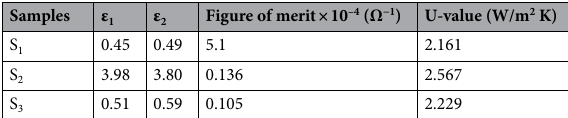
Figure of merit × 10 –4 (Ω −1 ) U-value (W/m 2